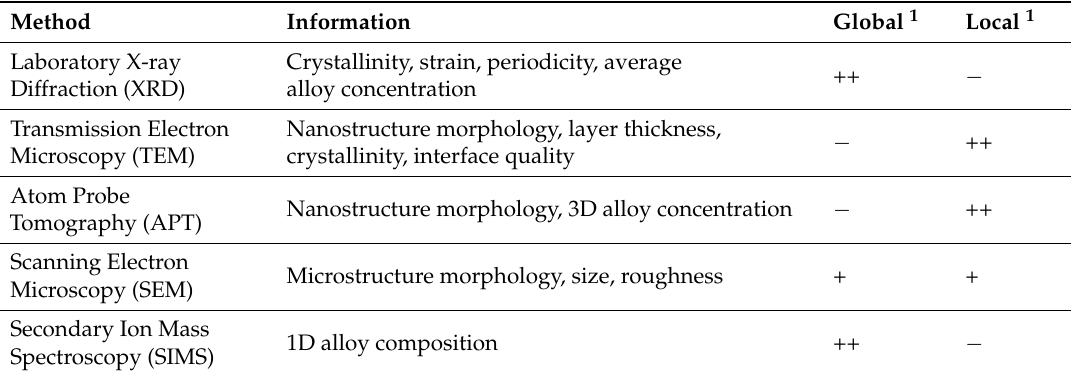
Table 1. Summary of methods used for material characterization of the active